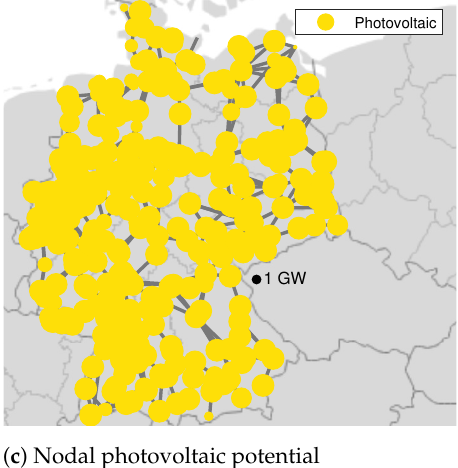
Figure 6. Available potential of variable renewable energy sources on nodal